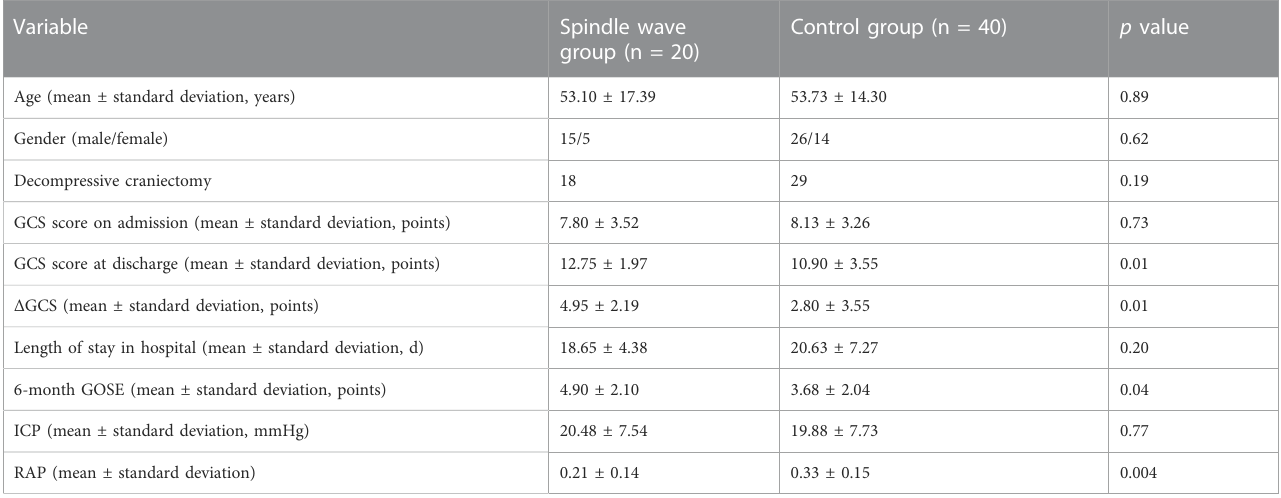
TABLE 1 Comparison of baseline information between the two groups.